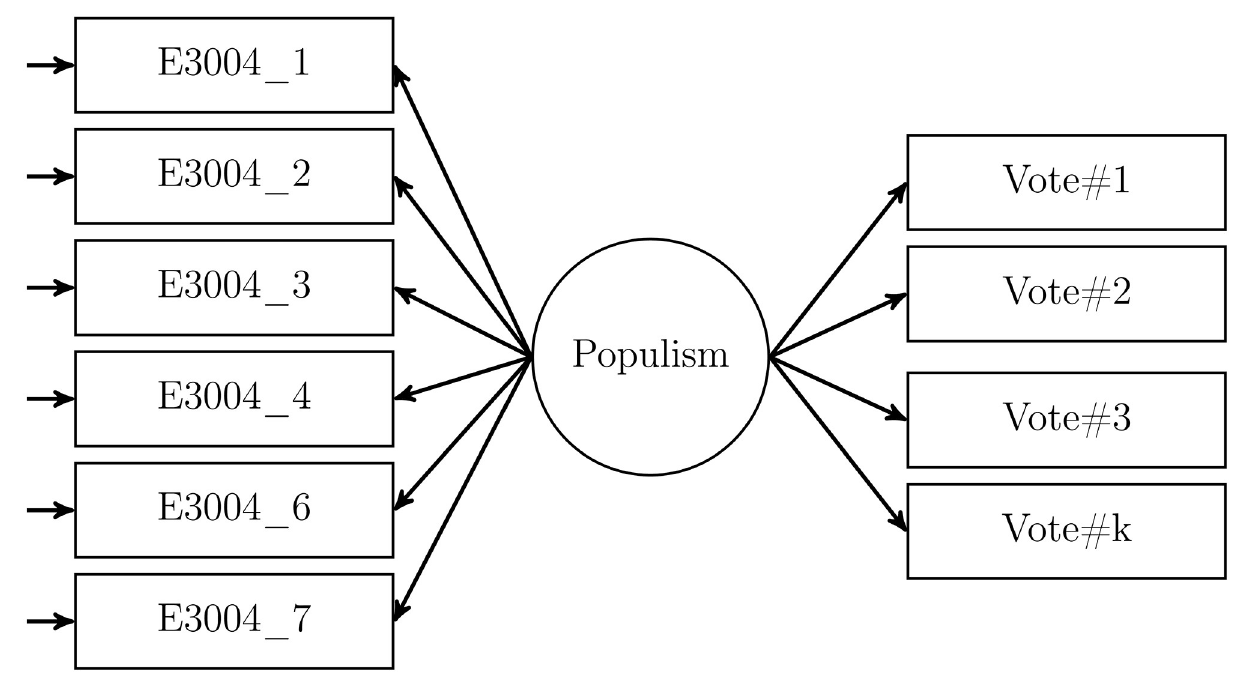
Fig 1. Multinomial SEM